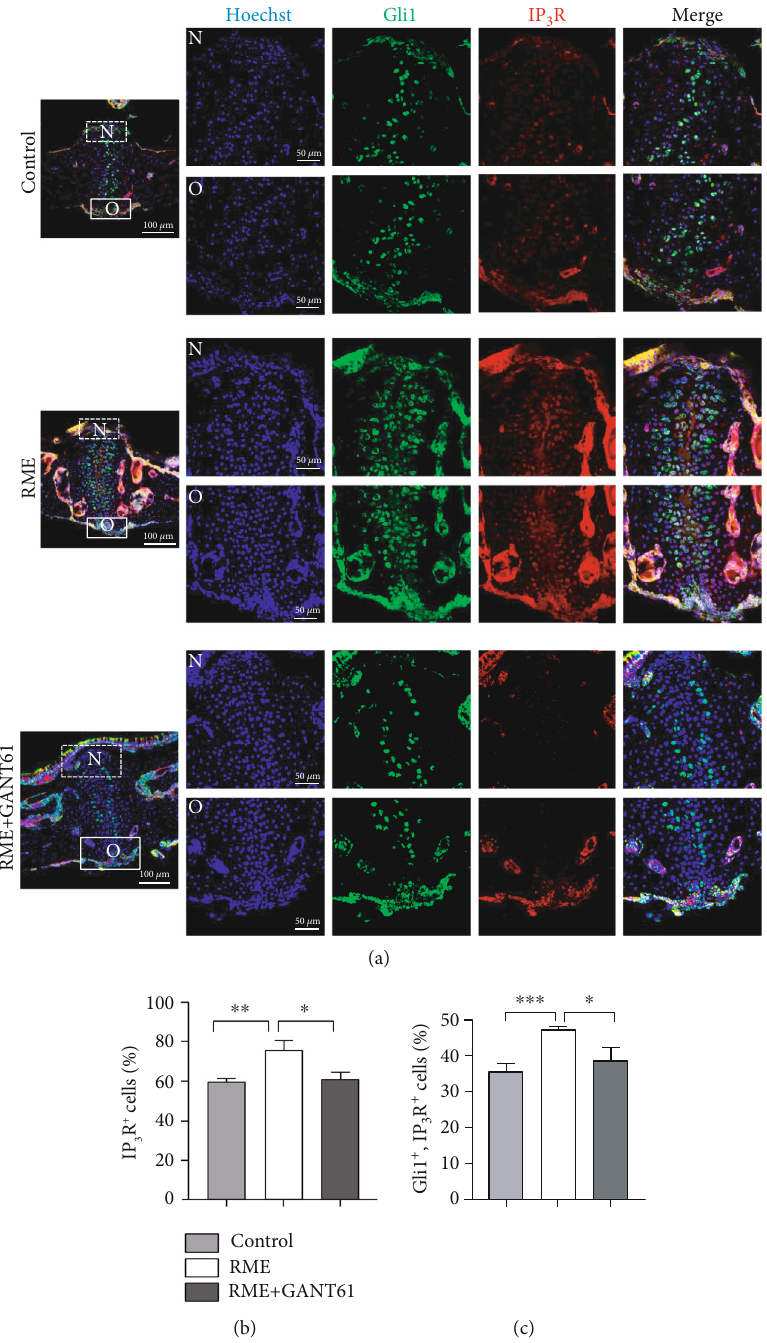
Figure 6: Gli1 + cells participate in RME-induced bone formation via IP R upregulation. (a) Distribution of IP R + cells (red), Gli1 + cells 3 3 (green), and IP R + and Gli1 + cells in the control, RME, and RME+GANT61 groups detected with immuno fl uorescence staining. Scale bar: 3 100 μ m. Regions in boxes are magni fi ed in the right panel: “ N ” indicates the nasal side of the midpalatal suture and “ O ” indicates the oral side. Scale bar: 50 μ m; n = 3 . (b) IP R + cells were increased in the RME group and decreased after GANT61 treatment. ∗ P < 0 : 05 ; ∗∗ P < 3 0 : 01 ; n = 3 . (c) IP R + and Gli1 + cells increased in the RME group and decreased after GANT61 treatment. ∗∗∗ P < 0 : 005 ; ∗ P < 0 : 05 ; n = 3 3